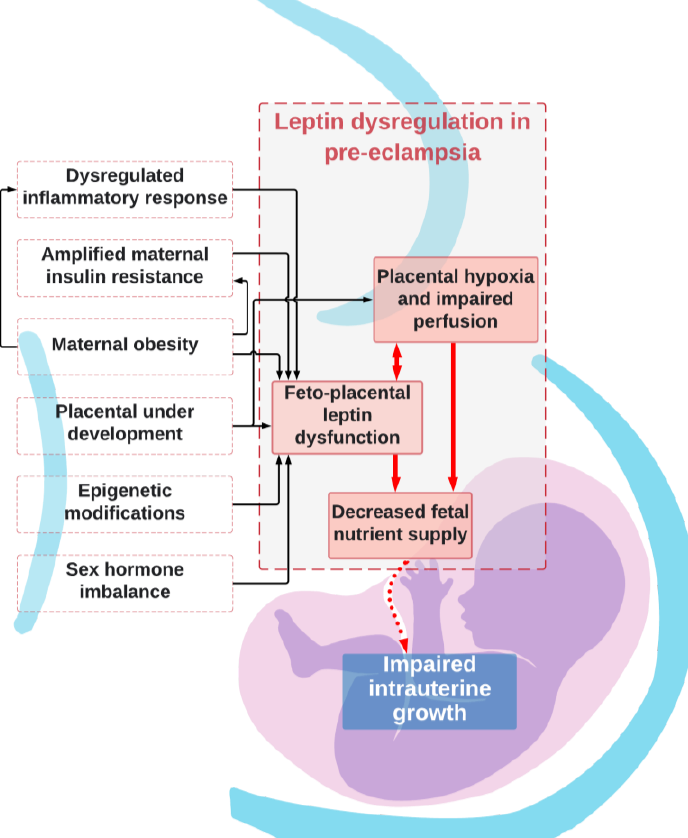
Figure 1. Leptin dysregulation in